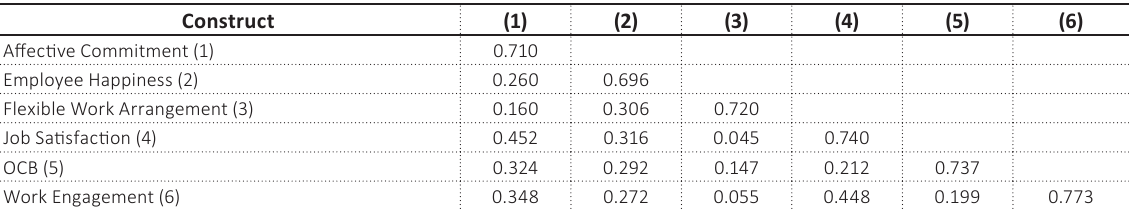
Table 3. Fornell-Larcker criterion